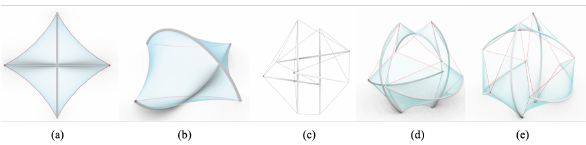
Figure 9: Floating-bending concept applied to different diamond- type modules with different number of bars [9].